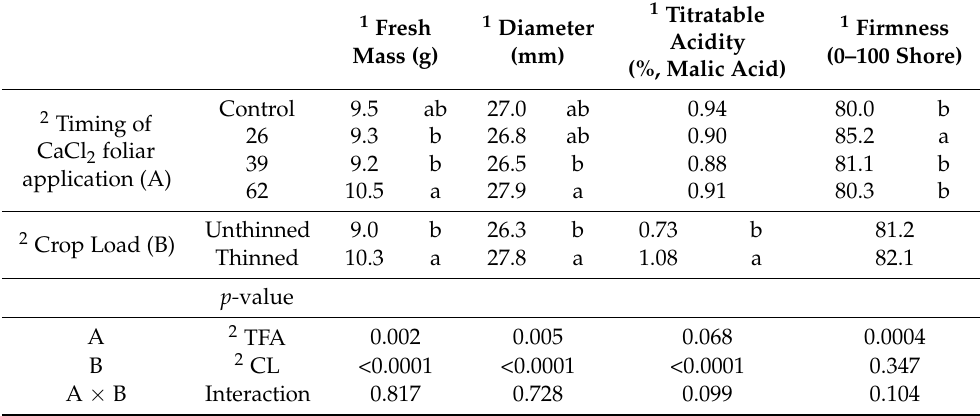
Table 4. Fruit quality in the sweet cherry combination ‘Lapins’/‘Colt’ at harvest, 90 days after full bloom (DAFB), was significantly affected by the timing of foliar CaCl 2 applications (a water control or a CaCl 2 spray at 26, 39, or 62 DAFB) and by crop load (natural unthinned vs. 50% thinned, 31 DAFB). There were no significant interactions between the timing of foliar CaCl 2 application and fruit thinning for: fruit fresh mass, diameter, TA, or firmness.